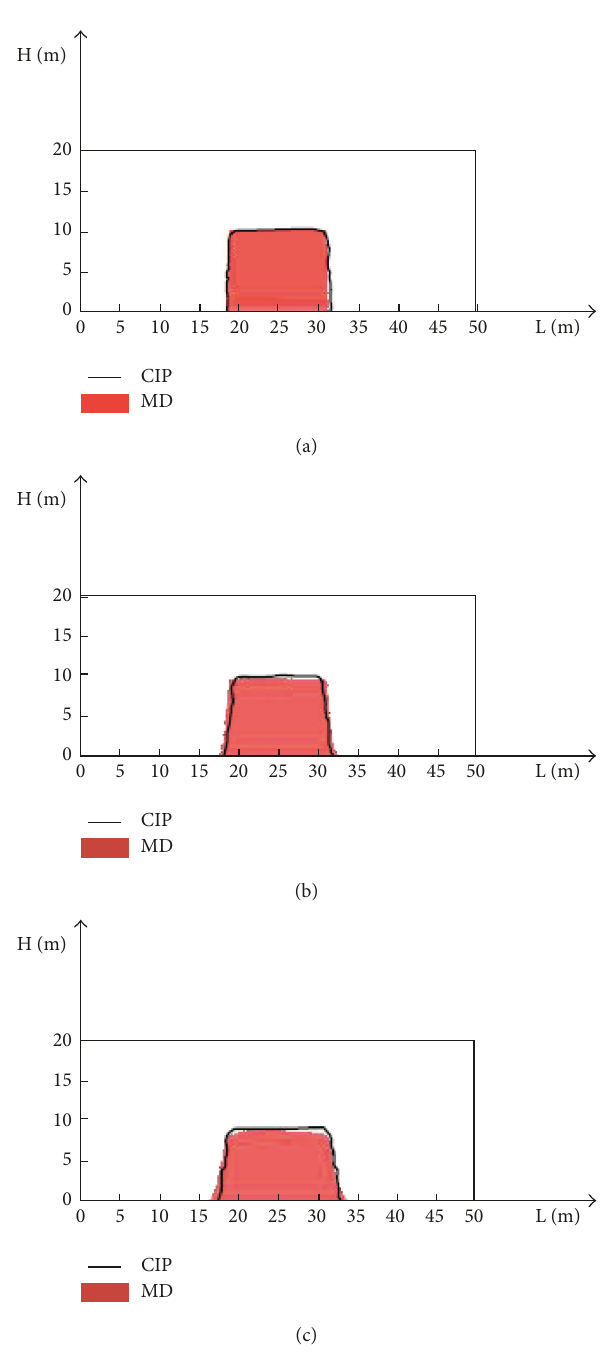
Figure 3: Comparisons of MD and CIP results. (a) t � 0.1s. (b) t � 0.5 s. (c) t � 1.0s.